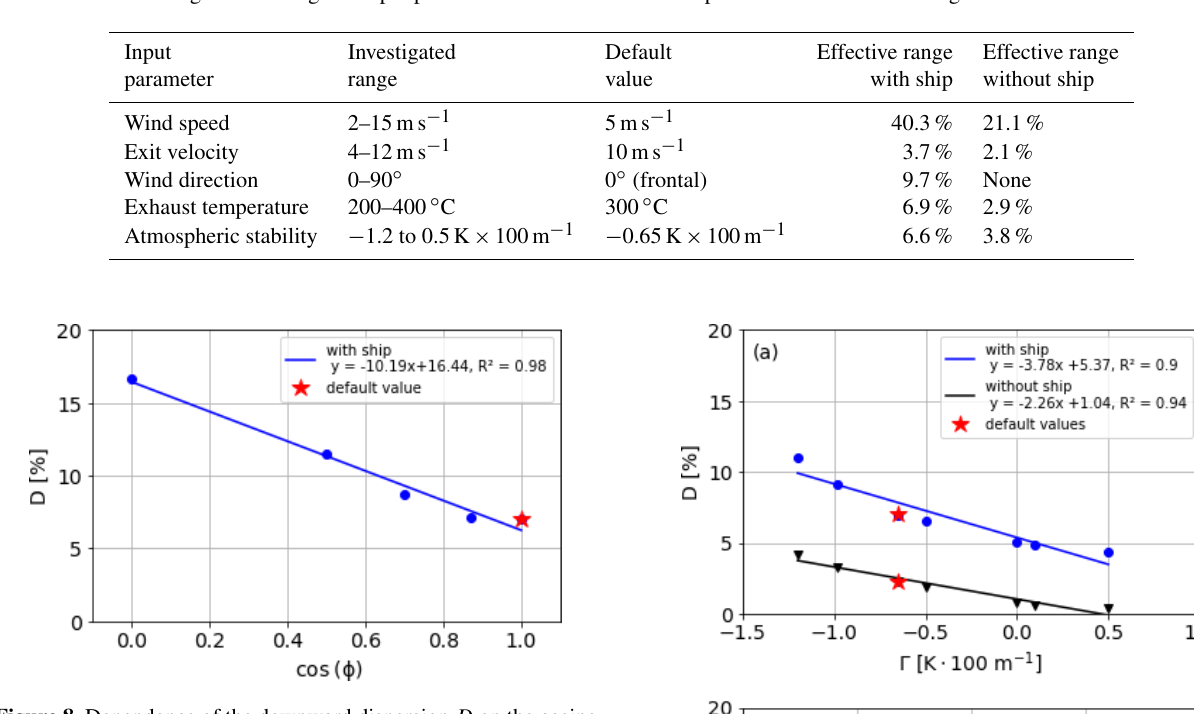
Table 2. Effective ranges of investigated input parameters on the downward dispersion under default settings.